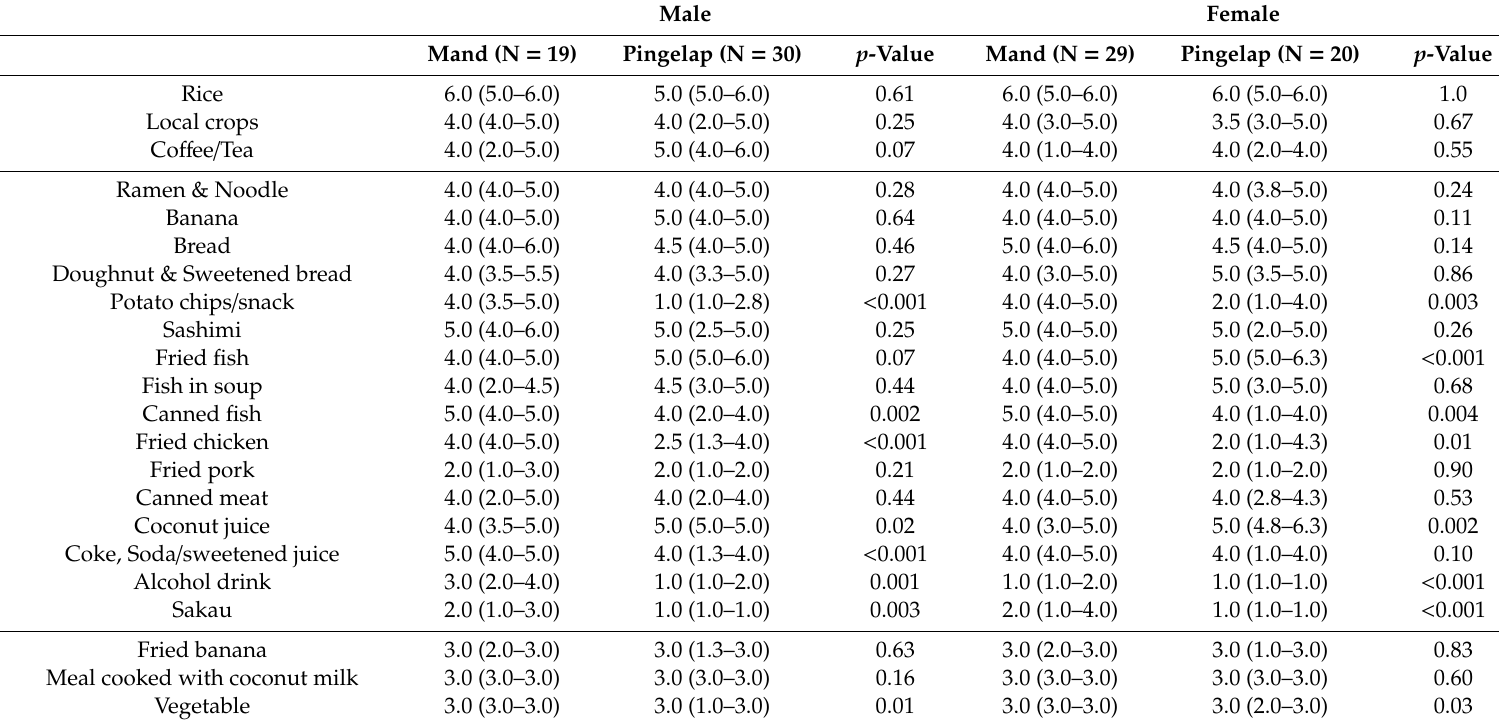
Table 5. Comparison of habitual diet from food frequency questionnaire between two communities separately for men and women (median (interquartile